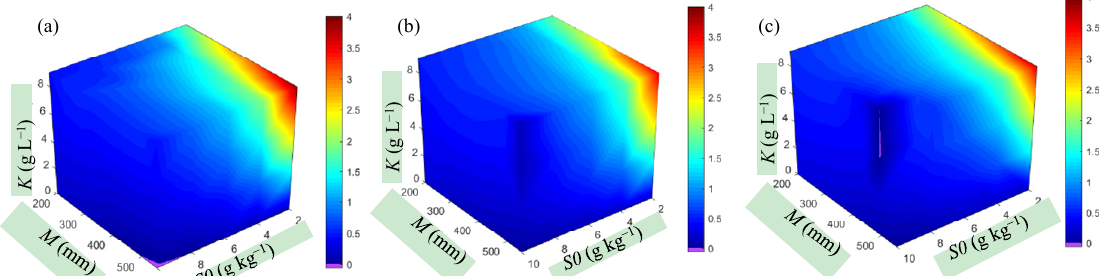
Figure 11. Salt accumulation under different scenarios: ( a ) W 0 = 0.7 θ fc ; ( b ) W 0 = 0.85 θ fc ; ( c ) W 0 = θ fc ; % salt accumulation = (soil salt content at end of growth period − soil salt content at beginning of growth period) / soil salt content at beginning of growth period) × 100. Purple areas in the figure represent desalinated soil.